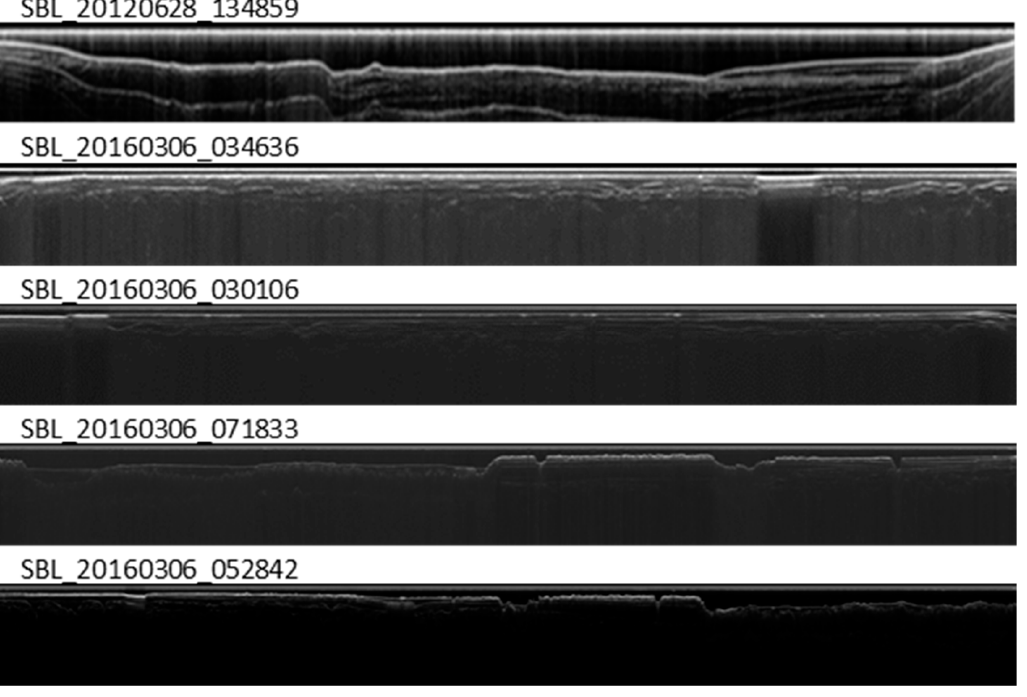
Figure 11. SBP images for training dataset.